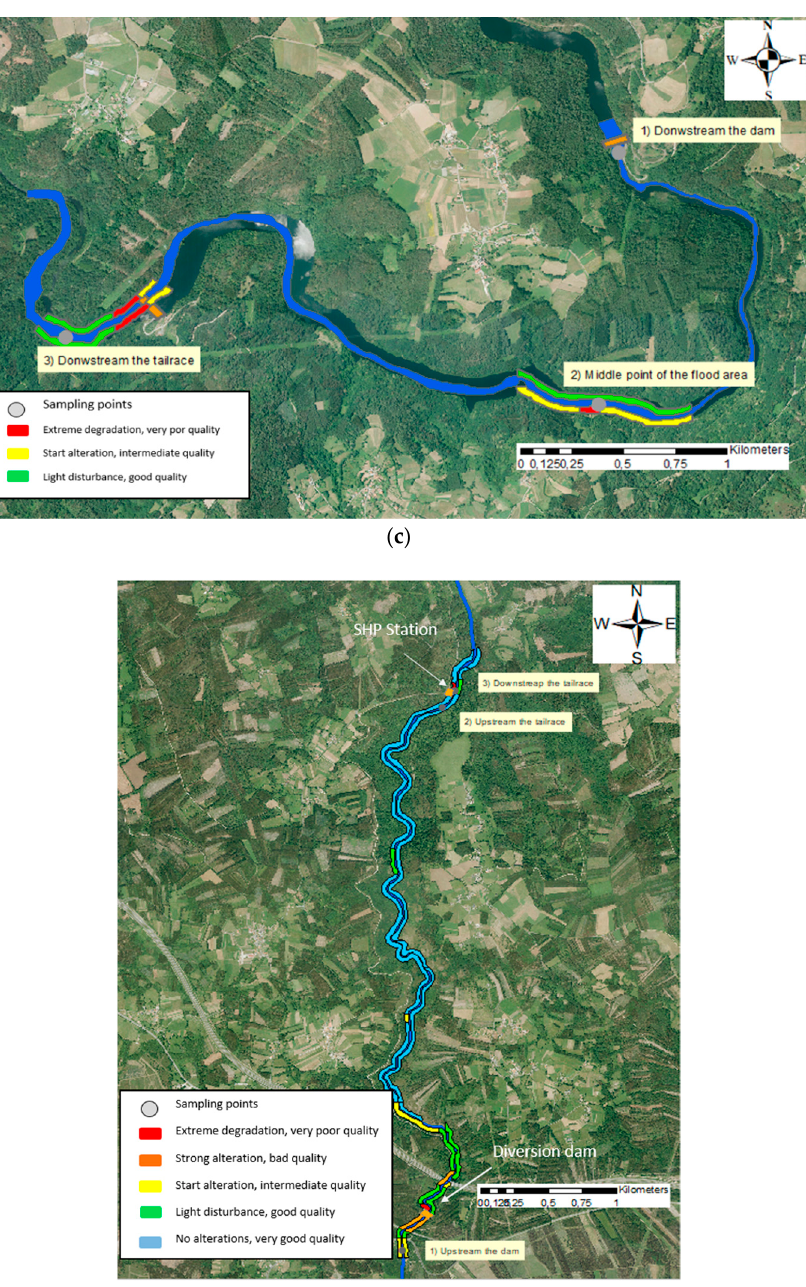
Figure 7. Riparian habitat quality index QBR in the reaches of the rivers ( a ) Lerez, ( b ) Umia, ( c ) Ulla and ( d ) Mandeo.